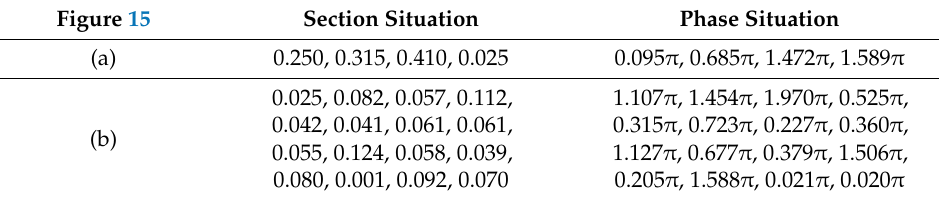
Table 6. Parameter settings of MPSM jamming with random sections and phase situation. Figure 15 Section